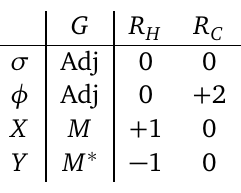
Table 2: Fields and